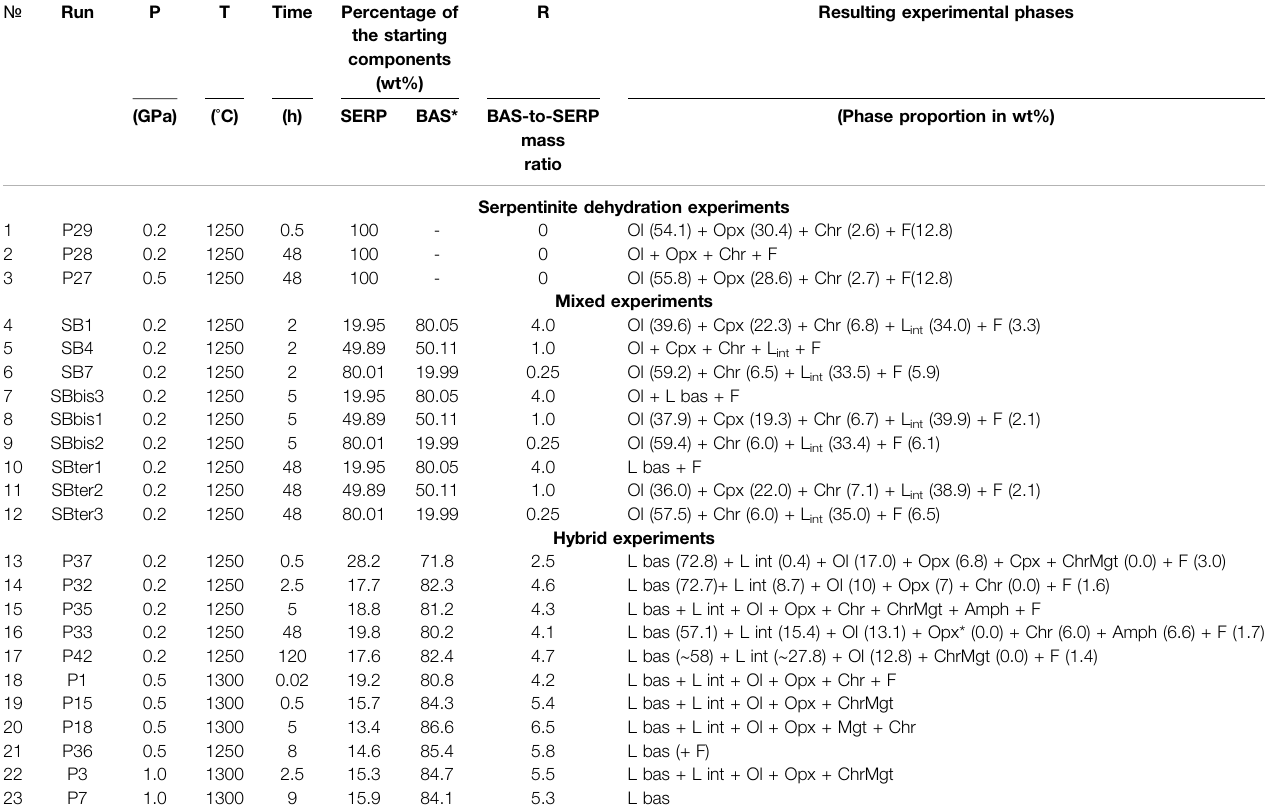
TABLE 1 | Experimental run conditions and the resulting phases with the phase